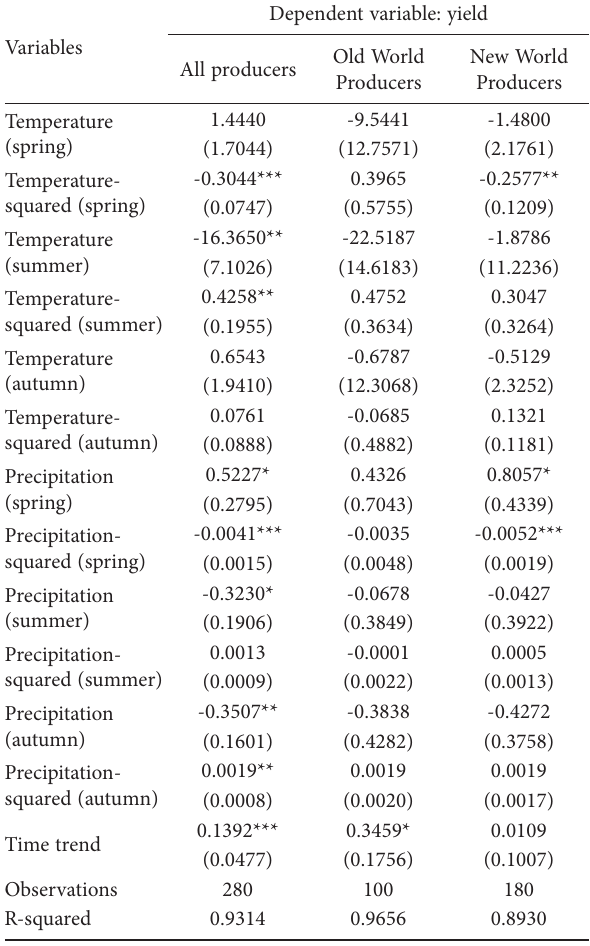
Table 2. Estimation results for grapevines yields,